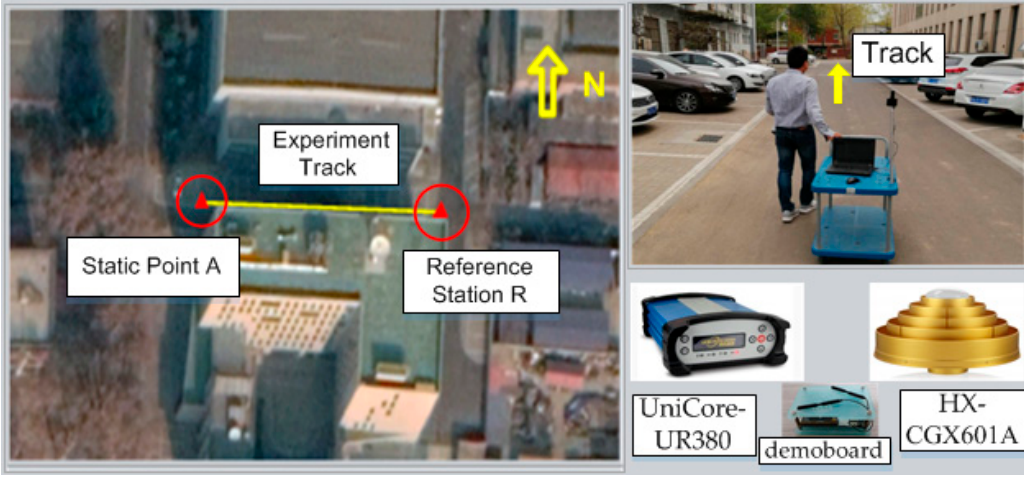
Figure 2. Kinematic test environment (experiment track shown with a yellow solid line).